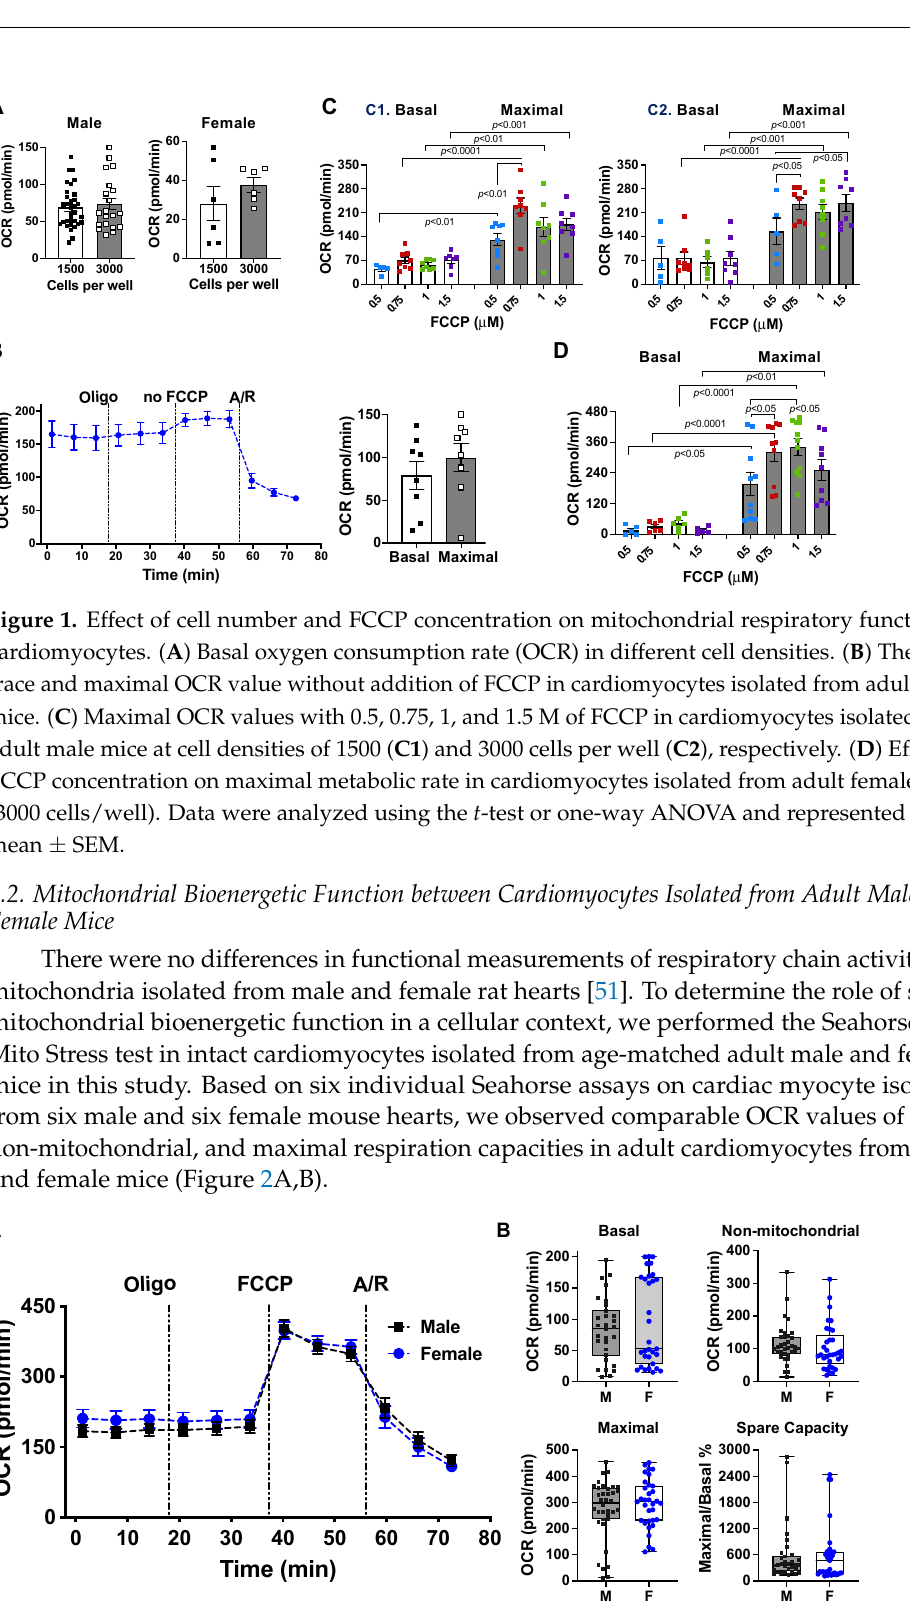
Figure 2. Metabolic profiling between cardiomyocytes isolated from adult male and female mice following addition of oligomycin (Oligo), FCCP, and Antimycin A/Rotenone (A/R). ( A ) The OCR trace. ( B ) Calculated values for mitochondrial basal, non-mitochondrial, maximal, and spare respira- tory parameters between cardiomyocytes isolated from male (M) and female (F) mice. Data were evaluated using the Mann–Whitney test in B and shown as box and whiskers plots with a dot for each individual measurement. The results are from six mouse hearts of each sex in six